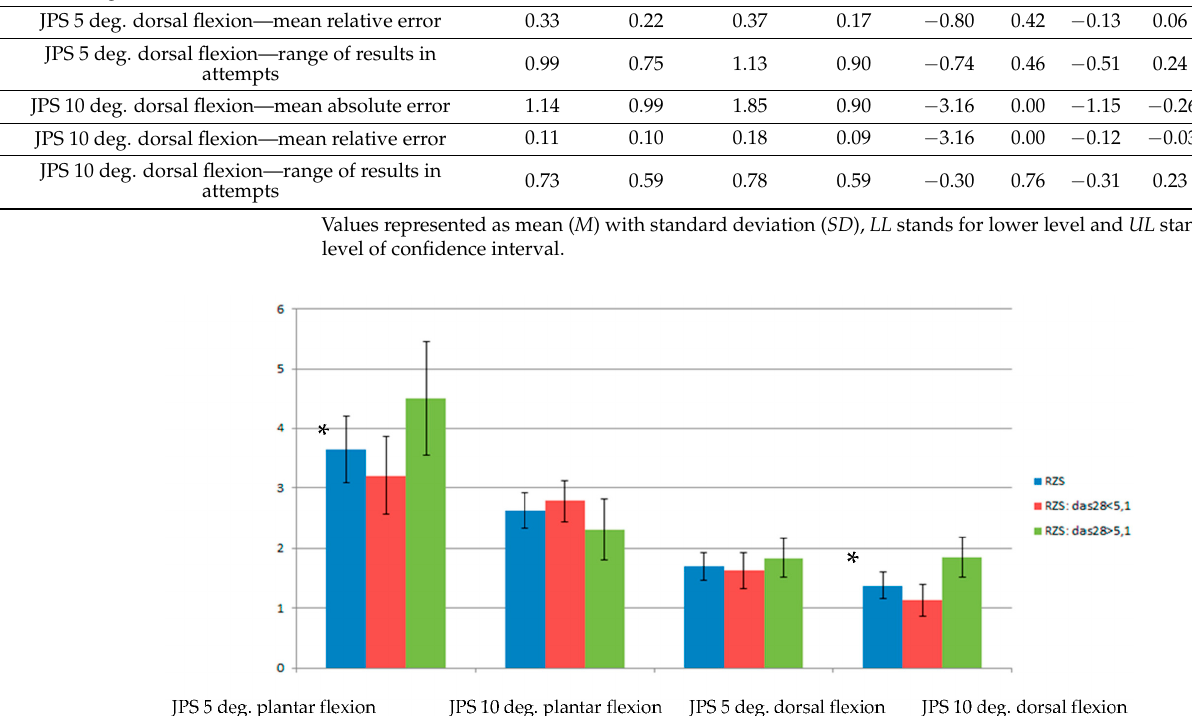
Figure 2. Comparison of chosen results of JPS assessment between RA groups: blue color column represents all patients, red column represents patients with moderate activity of disease, green represents patients with high activity of the disease, * p < 0.05. Table 4. Comparison of the results of JPS assessment between groups for both lower limbs based on the activity of the disease.